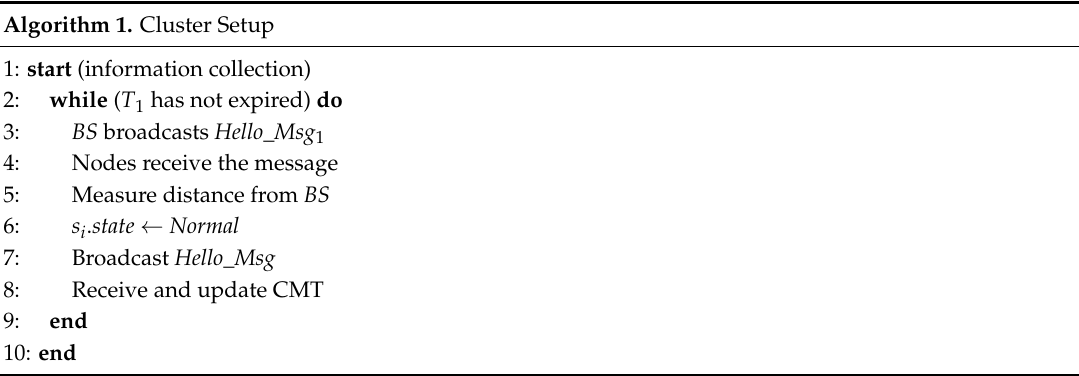
Algorithm 1. Cluster